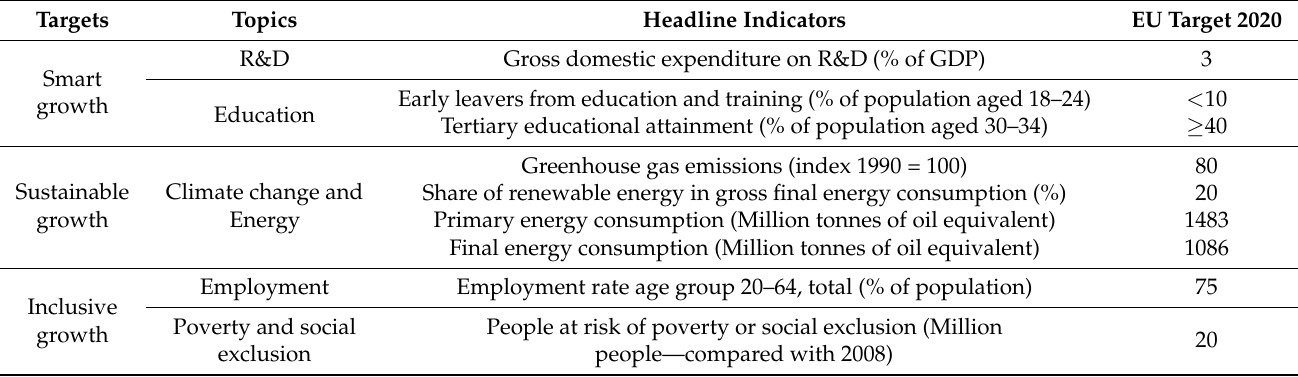
Table 1. Targets, topics and indicators of the Europe 2020